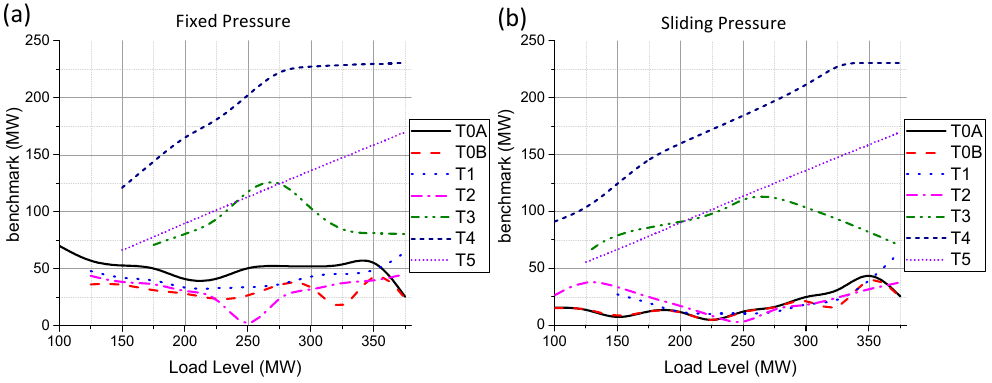
Figure 12. The benchmark value in FP ( a ) and SP ( b ) operating mode.